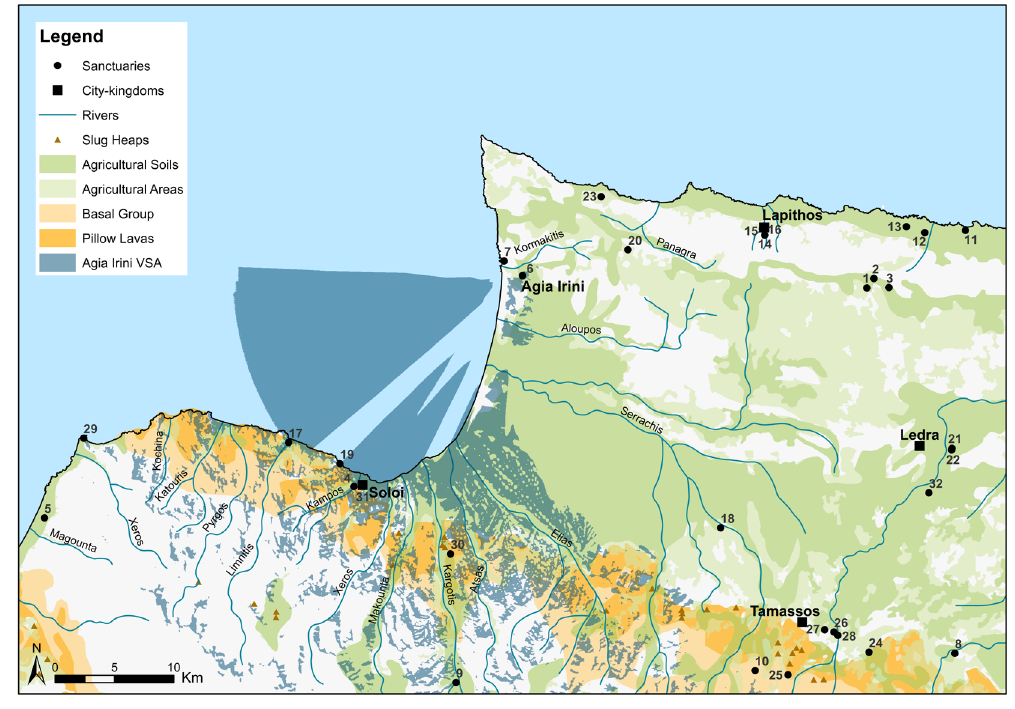
Figure 3: Viewshed analysis from the Agia Irini sanctuary; digital data courtesy of the Geological Survey Department, Cyprus (GIS analysis by Charalambos